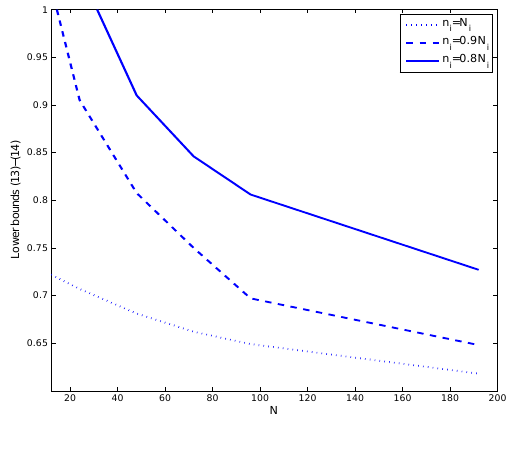
Fig. 2. Lower bounds (13)-(14) versus the cardinality N of secondary network. = 0.1.